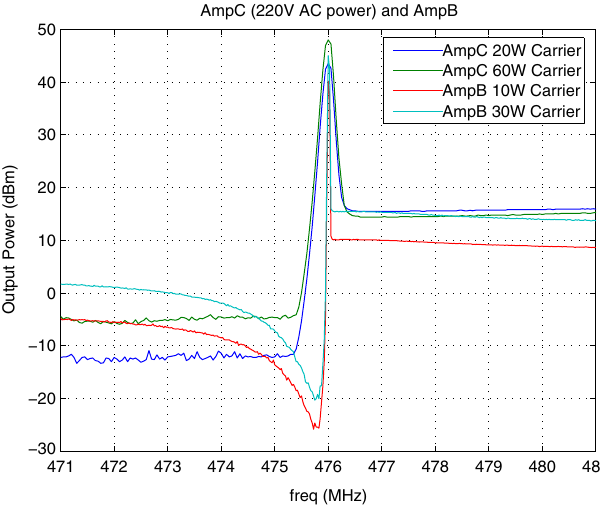
FIG. 23. (Color) Swept sideband image response for amplifier ‘‘B’’ and ‘‘C’’ from [31].